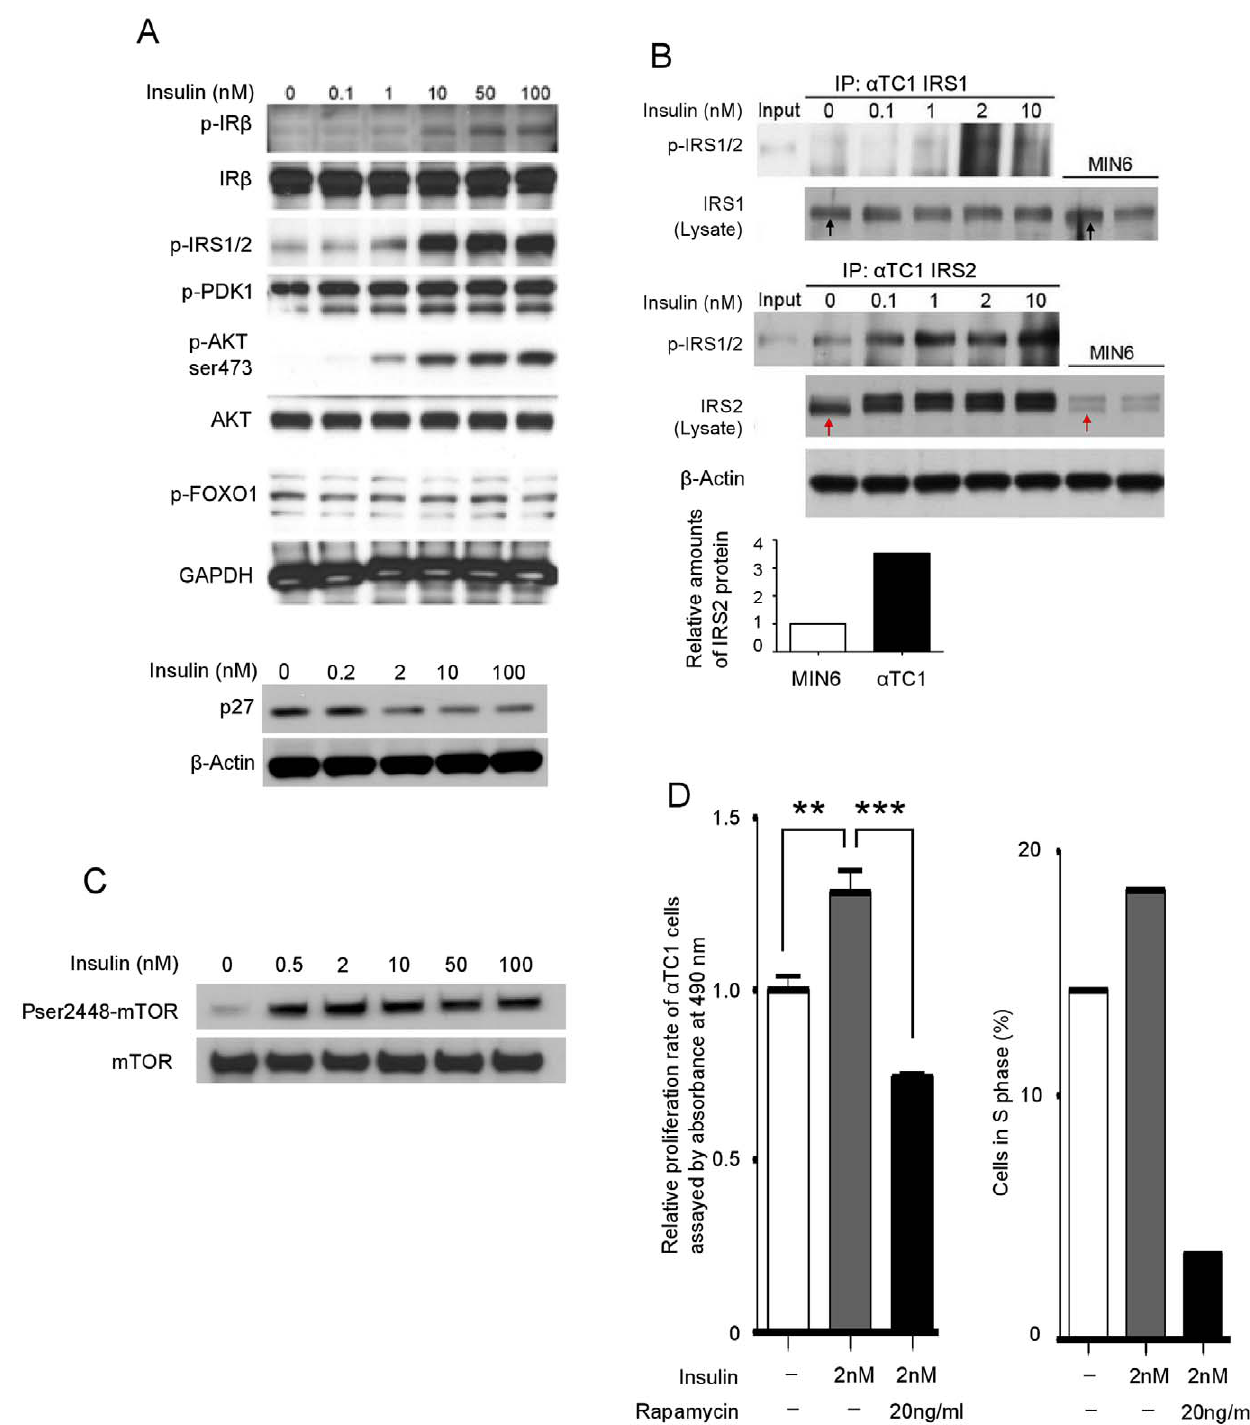
Figure 4. IRs signal through IRS2 and AKT and activate mTOR, resulting in a -cell proliferation. (A) Western blot analysis of insulin receptor signaling molecules in a cells. a TC1 cells were treated with increasing concentration of insulin for 10 minutes and whole cell lysate was used for western blotting. (B) Immunoprecipitation of IRS1 and IRS2 in pancreatic cells. a TC1 cells were treated with increasing concentrationof insulin for 10 minutes and whole cell lysates was collected. IRS1 and IRS2 proteins were immunoprecipitated, and immunoblotted with an antibody that recognizes phosphorylated IRS1/2 (Tyr612). Protein levels of IRS1 (black arrows) and IRS2 (red arrows) in a TC1 and MIN6 cells. The densitometry represents relative expression of IRS2 protein levels. (C) a TC1 cells were treated with increasing concentration of insulin for 10 minutes and whole cell lysate was blotted for phosphorylated and total mTOR. (D) a -TC1 cells were treated for 72 hours (left panel) or 24 hours (right panel) with insulin (2 nM) + / 2 rapamycin (20 mg/ml). The cell proliferation was assessed by both ELISA-based relative proliferation assay (left panel: data are expressed as means 6 SEM [n=6]; ** p , 0.005, *** p , 0.0005) and by counting the cells in S phase (propidium iodide staining for DNA cell cycle analysis) (right panel).